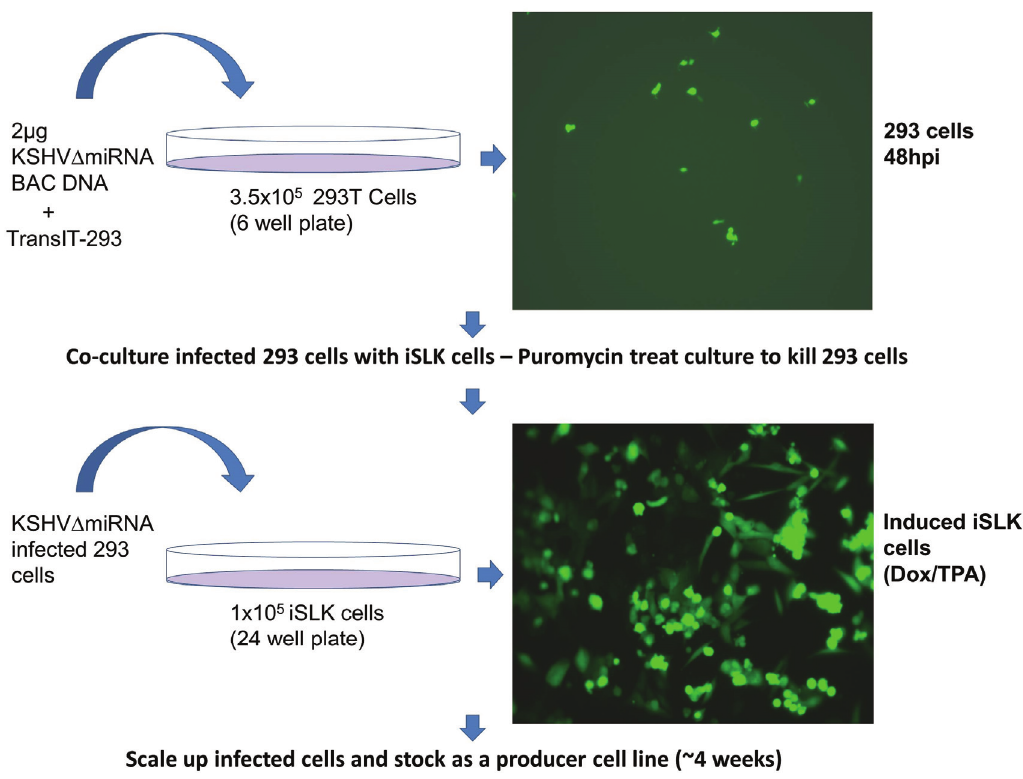
Figure 4. Generation of iSLK producer cell lines by co-culture with bacmid-transfected 293